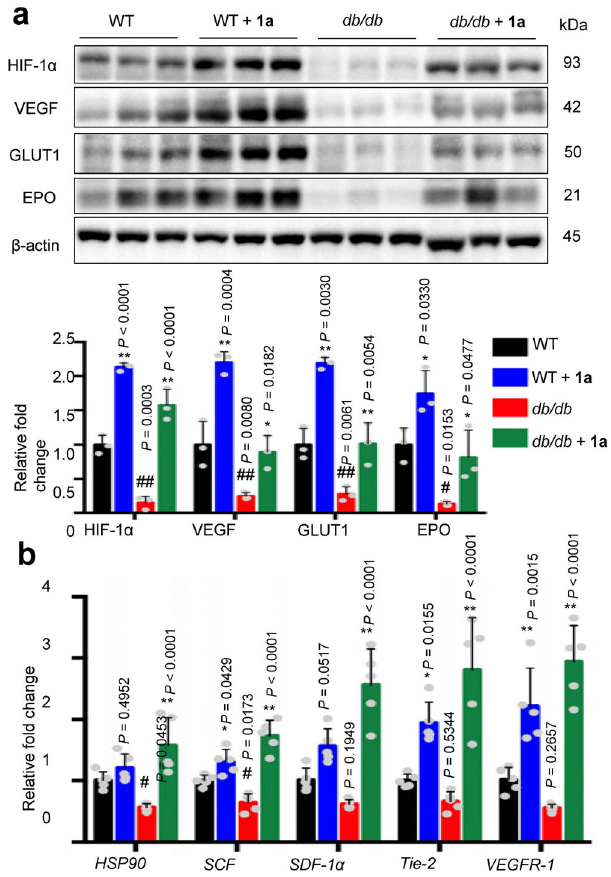
Fig. 5 Complex 1a (0.25 mg/mL) activates gene expression regulated by HIF-1 α in db/db mice at 8 days post-injury. a Western blot analyses and quantitation of HIF-1 α , VEGF, GLUT1, and EPO in wound tissue ( n = 3 mice). All proteins were normalized by β -actin. b The mRNA levels of HIF- 1 α target genes involved in wound healing were analyzed by qRT-PCR in wound tissues ( n = 5 mice). Data are expressed as means ± SD, P values were calculated using a one-way ANOVA with Tukey ’ s